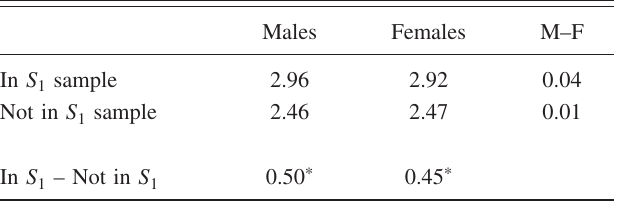
TABLE VIII. Average course grades for students included in the first regression sample (cid:1) S 1 (cid:2) and those who are not in the S 1 sample. Course grades are on a 0.0 to 4.0 scale. The asterisk (cid:1) (cid:1) (cid:2) indicates that the differences are significant (cid:1) p (cid:1) 0.05 (cid:2) .